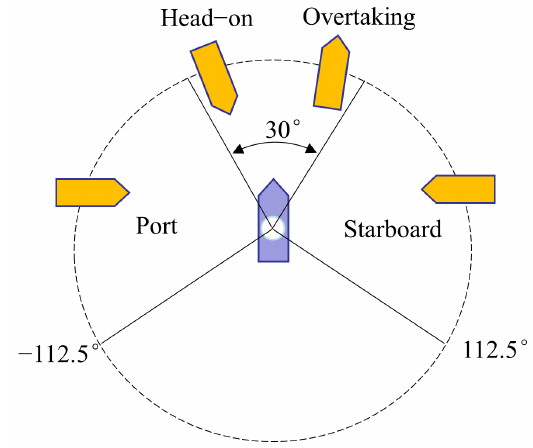
Figure 6. Definition of different encounter scenarios.